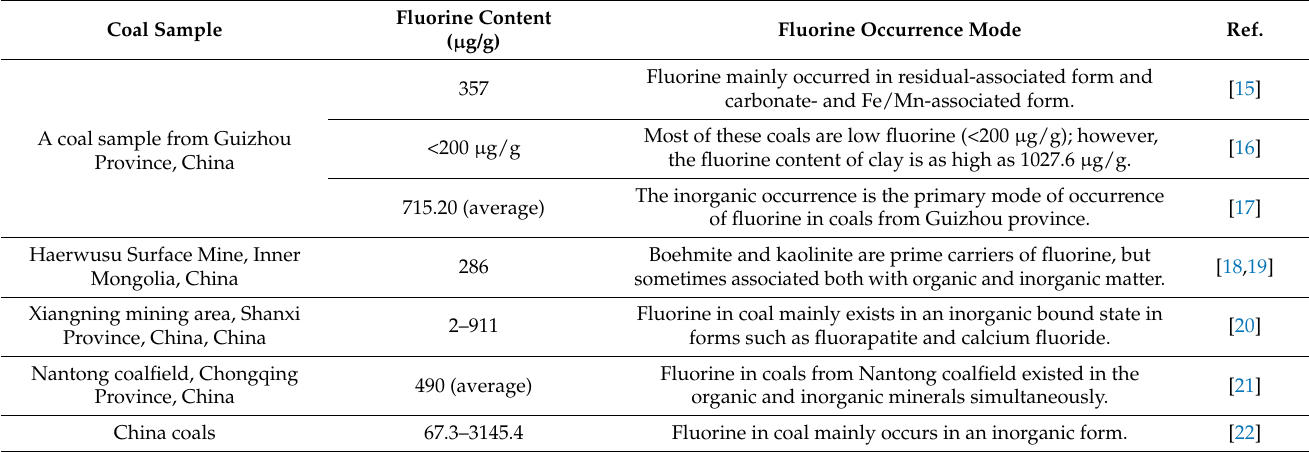
Table 1. A summary of the fluorine content and occurrence modes in some Chinese